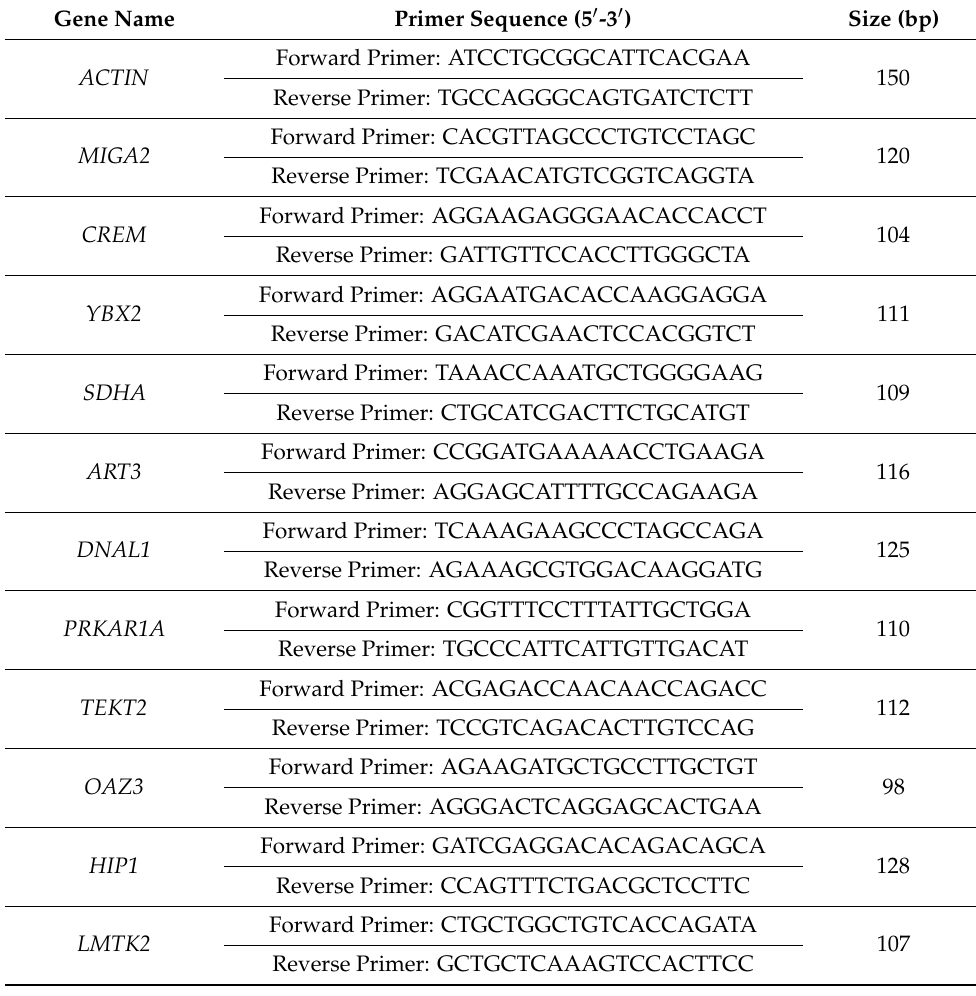
Table 2. Primers used for qPCR analysis of bovine